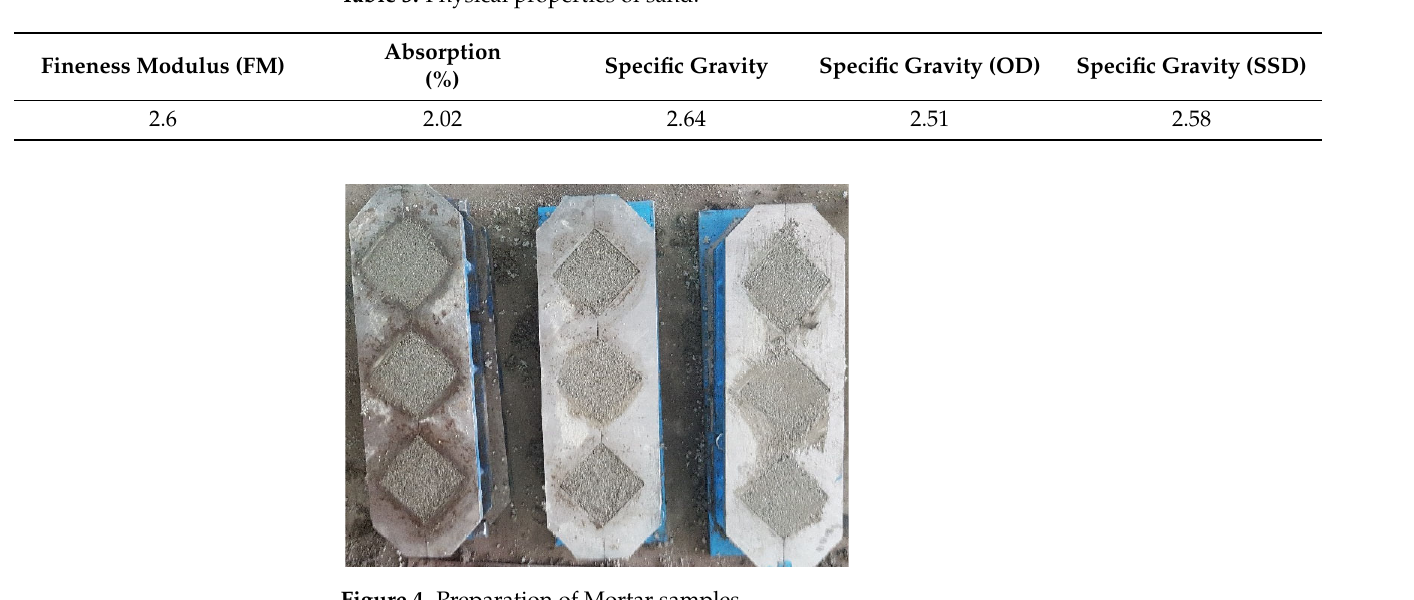
Figure 5. Mortar sample crack formation (schematic diagram) . Healed crack areas represent the healing impact of the repair solution. It is critical to assess the healed area to determine the effectiveness of the repair process. A digital image processing approach was used to extract the crack features [31–35]. Before the ap ‐ plication of any repair, high ‐ definition images were captured with subsequent crack fea ‐ ture extraction. After loading the image into MATLAB, an image processing algorithm was applied. Initially, an RGB (Red–Green–Blue) image was transformed into a binary image using OTSU ‐ based image thresholding algorithms as shown in Figure 6 [33,36]. The image was cleaned after the crack region was identified. No ‐ crack objects, noisy pix ‐ els, and places other than the intended crack were deleted, as well as the picture’s edge smoothing. After removing unwanted pixels, the crack width (mm) and crack area per ‐ centages (%) were calculated using Equations (8) and (9). Because measurements on the edges are questionable, the core 40 mm crack length was evaluated, and a 5 mm portion